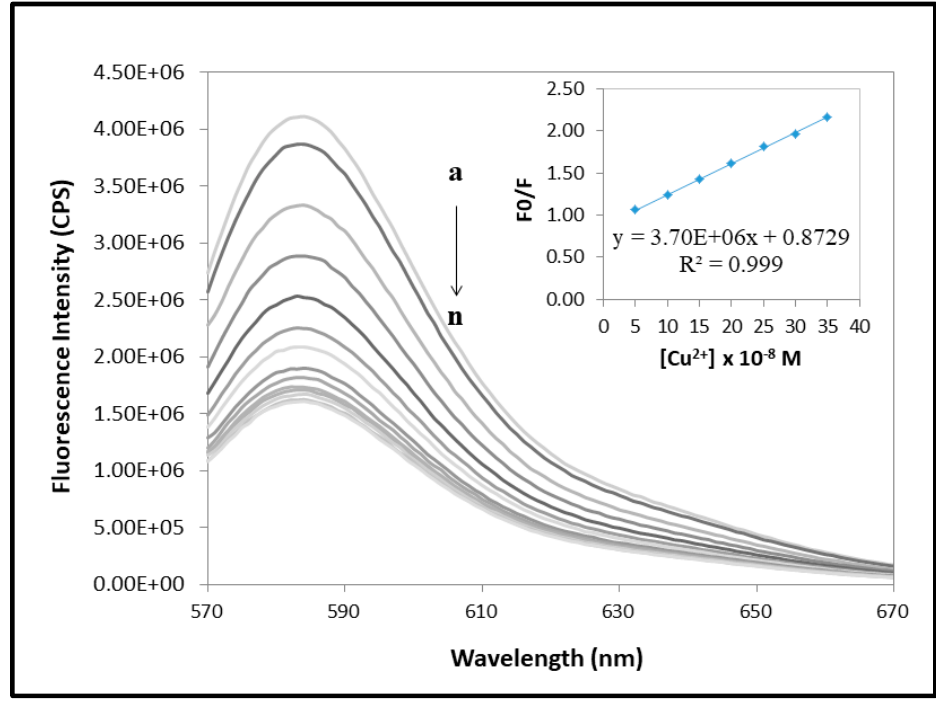
Figure 2. Fluorescence titrations ( λ ex : 583 nm) of Probe 3 (1 µM) in acid conditions (pH 4.7)